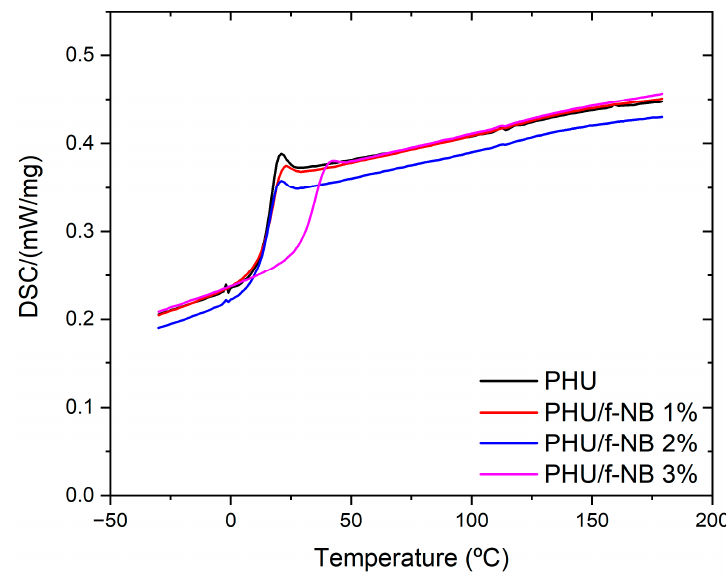
Figure 5. Storage modulus and damping factor (tan δ ) of the PHU films. The DSC curves of PHU films show comparable patterns with no melting of a crys- talline phase during the second heating, suggesting that all systems are amorphous (Fig- ure 6). The films with different percentages of f-BN present moderate to strong shifts in the glass transition temperatures (Table 1), corroborating the DMA results. As discussed previously, the shift is ascribed to both the presence of the f-BN restricting the segmental motion and cross-linking of the molecular network [18] ascribed to intramolecular hydro- gen bonding between the functional groups, i.e., hydroxyl, ethers, carbonyl, and the ure- thane bonds [45].